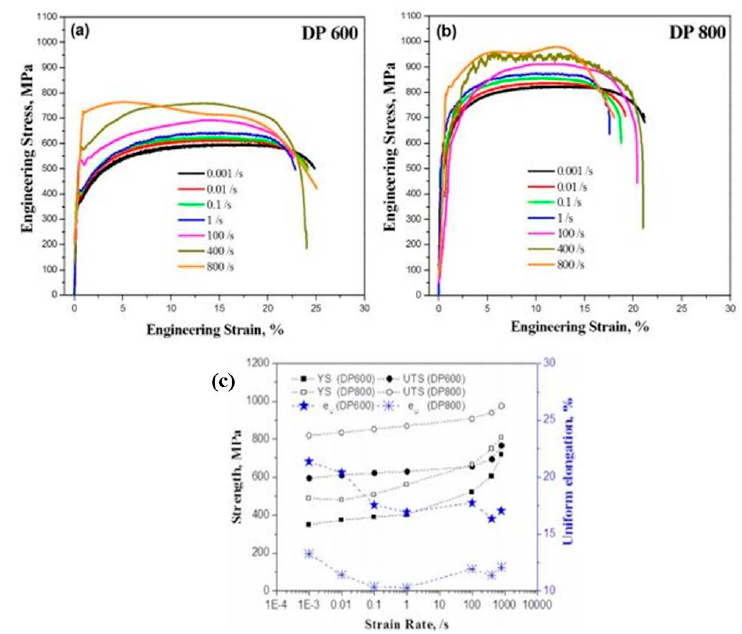
Figure 32. ( a ) Stress–strain curves for dual-phase (DP) 600, ( b ) stress–strain curves for DP 800, and ( c ) variation in the yield and ultimate tensile strength of DP600 and DP800 steel as a function of strain rate [178] .